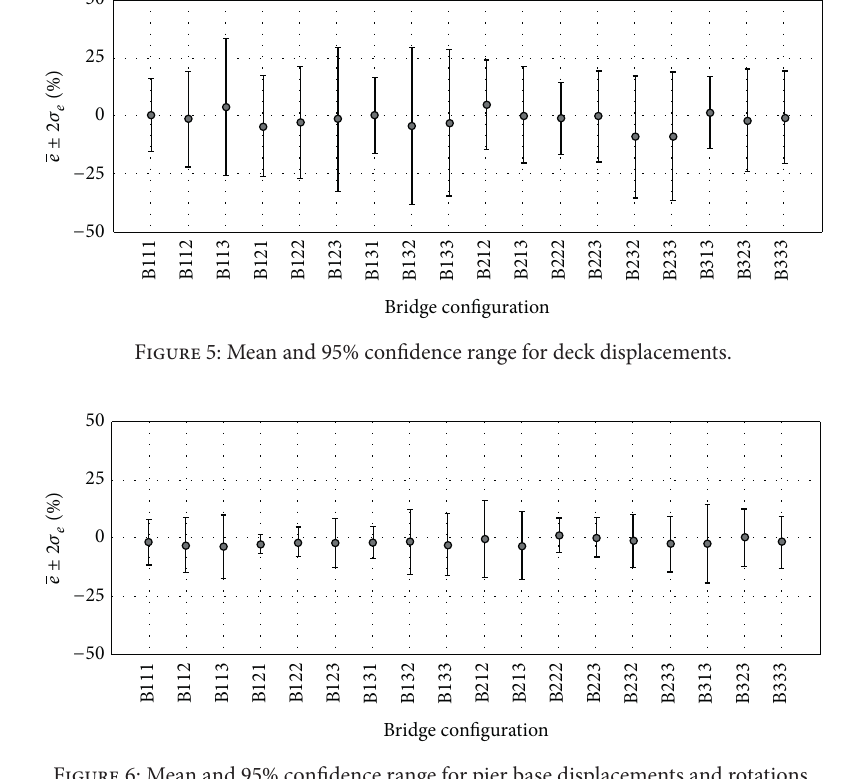
Figure 6: Mean and 95% confidence range for pier base displacements and rotations.